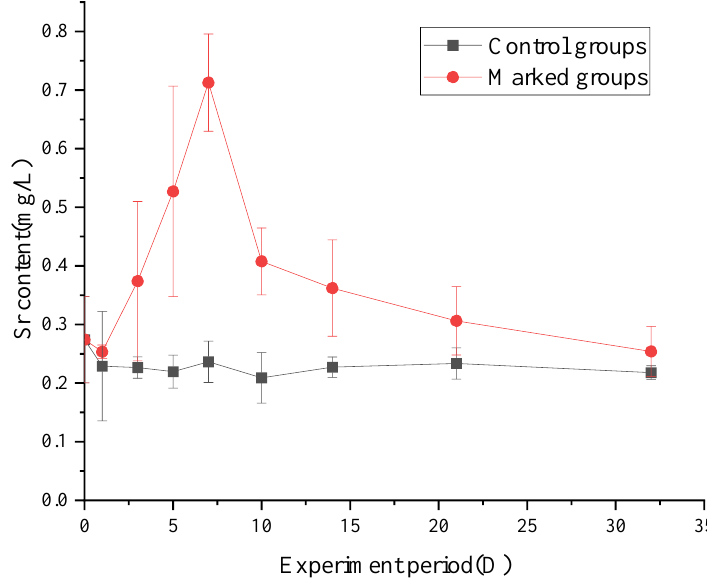
Figure 3. The variation trend of Sr 2+ in muscle of T. obscurus.